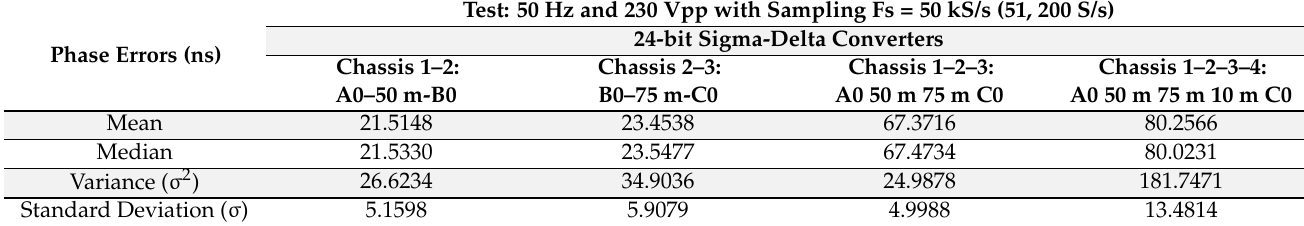
Table 6. Phase errors for 24-bit Sigma-Delta converters.